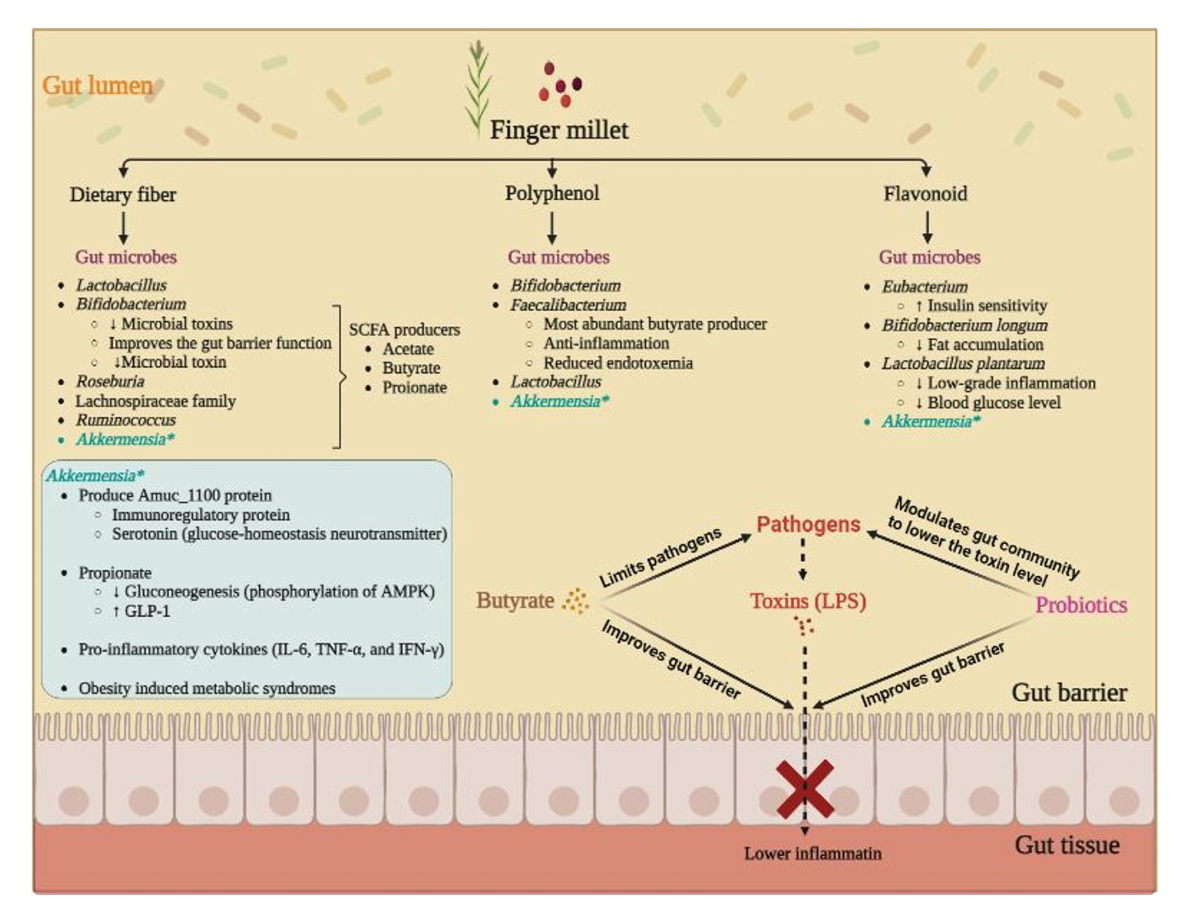
FIGURE1 Role of finger millet bio-active molecule induced gut microbes in alleviation of diabetes; butyrate producers Faecalibacterium , Roseburia , and Eubacterium play a crucial role in reducing systemic inflammation by maintaining the gut barrier function to avoid the gut invasion by pathogenic microbes and toxins. Mucus degrading Akkermansia , participates in glucose-homeostasis by means of Amuc_1100 protein and regulates the blood glucose and lowers the gut inflammatory load by releasing propionate. Probiotics ( Bifidobacterium and Lactobacillus ) also improves the toxin level by modulating the gut community, i.e., by lowering the various possible opportunistic pathogen, and simultaneously enhancing the beneficial